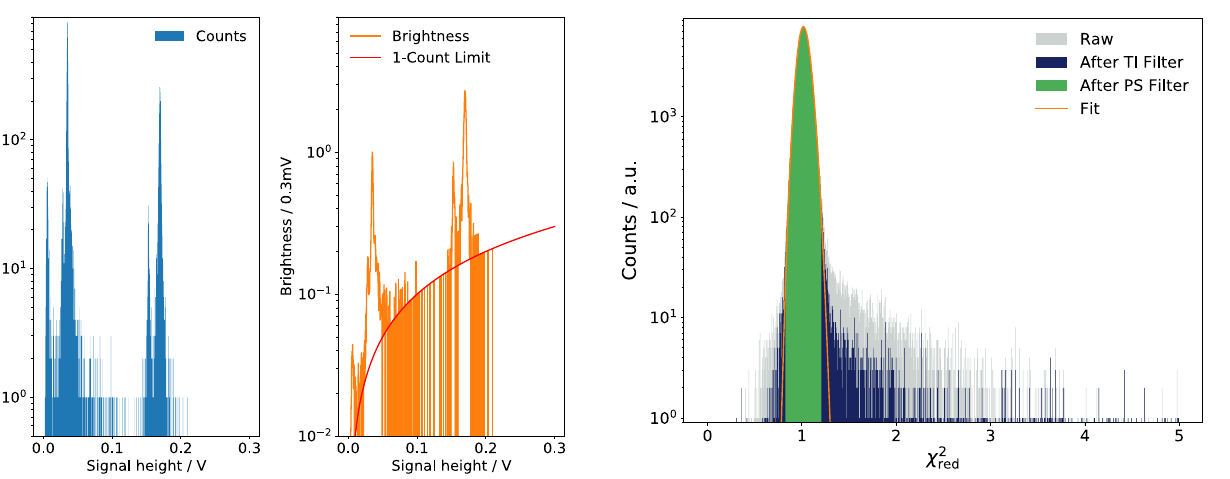
Fig. 6 Representationofthesignalheightsofthefirst10,000rawtraces of a single pixel. Left: histogram of the signal heights Right: brightness of the traces calculated via Eq.(7). One can clearly see that the MI-line is the brightest. This holds for much higher signal heights as well, as highlighted by the 1-count limit in red. The number of bins (1000) is chosensimplyforopticalclarityandonlyslightlyinfluencestheposition of the maximum